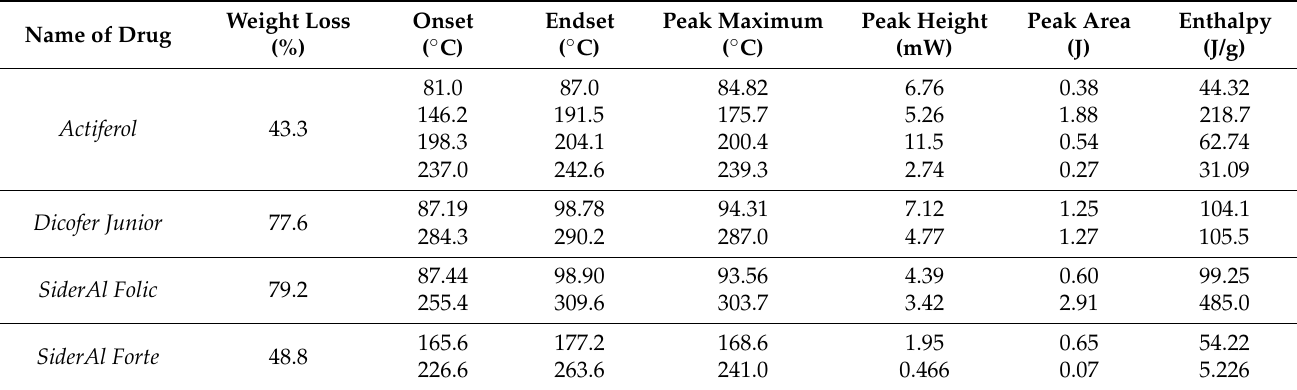
Table 8. Parameters determined from TG and DSC analysis for drugs containing iron (III) pyrophos- phate.